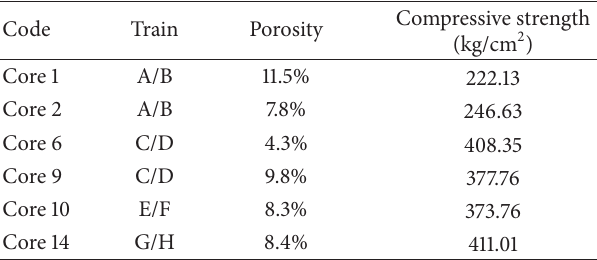
Table 4: Porosity test of concrete core-drilled samples.